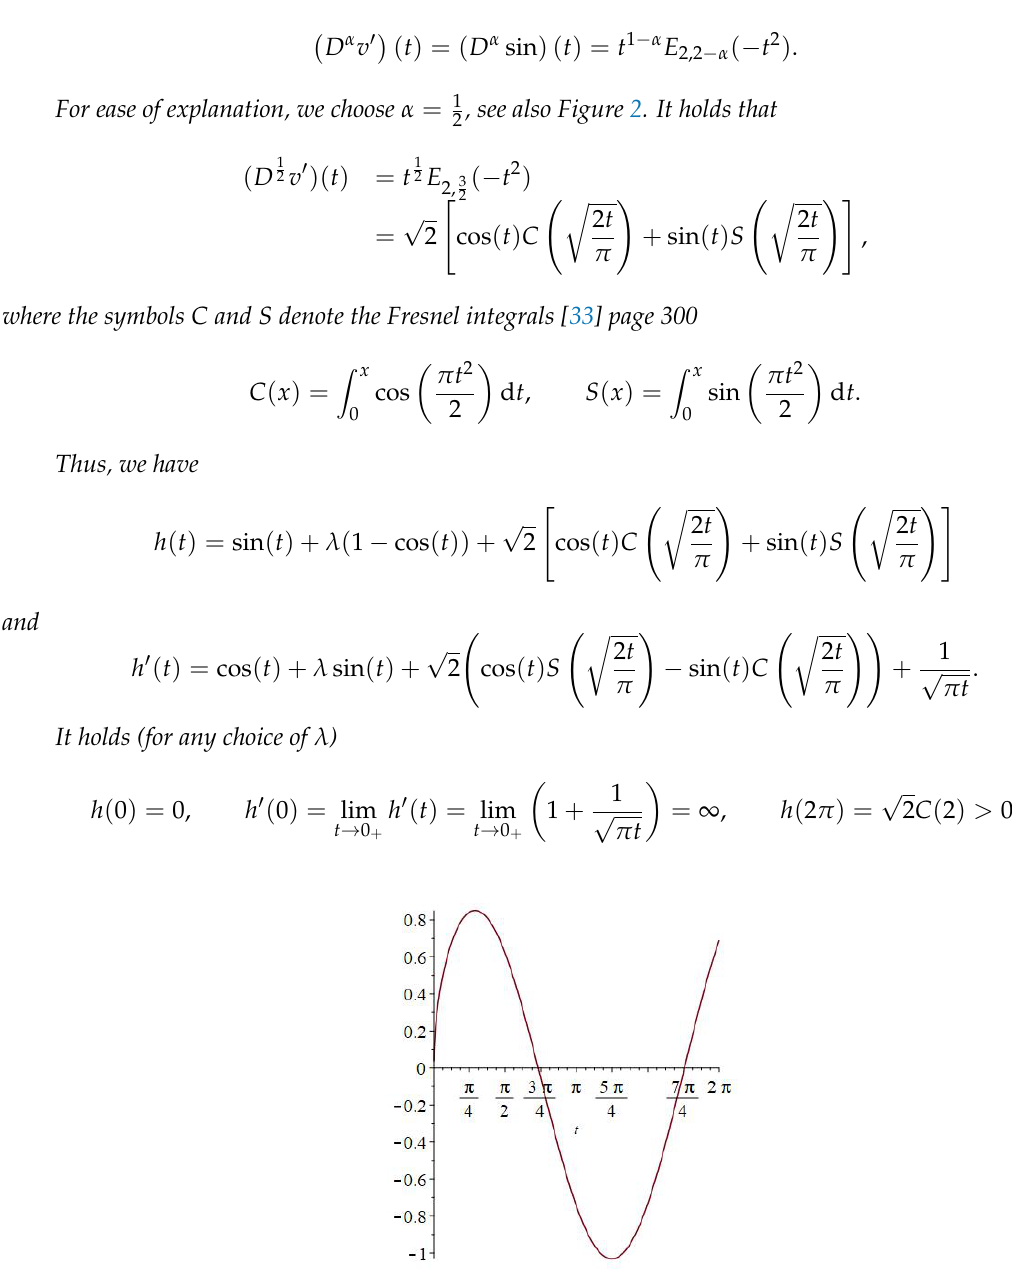
Figure 2. Graph of the Caputo fractional derivative ( D 1/2 sin )( t )